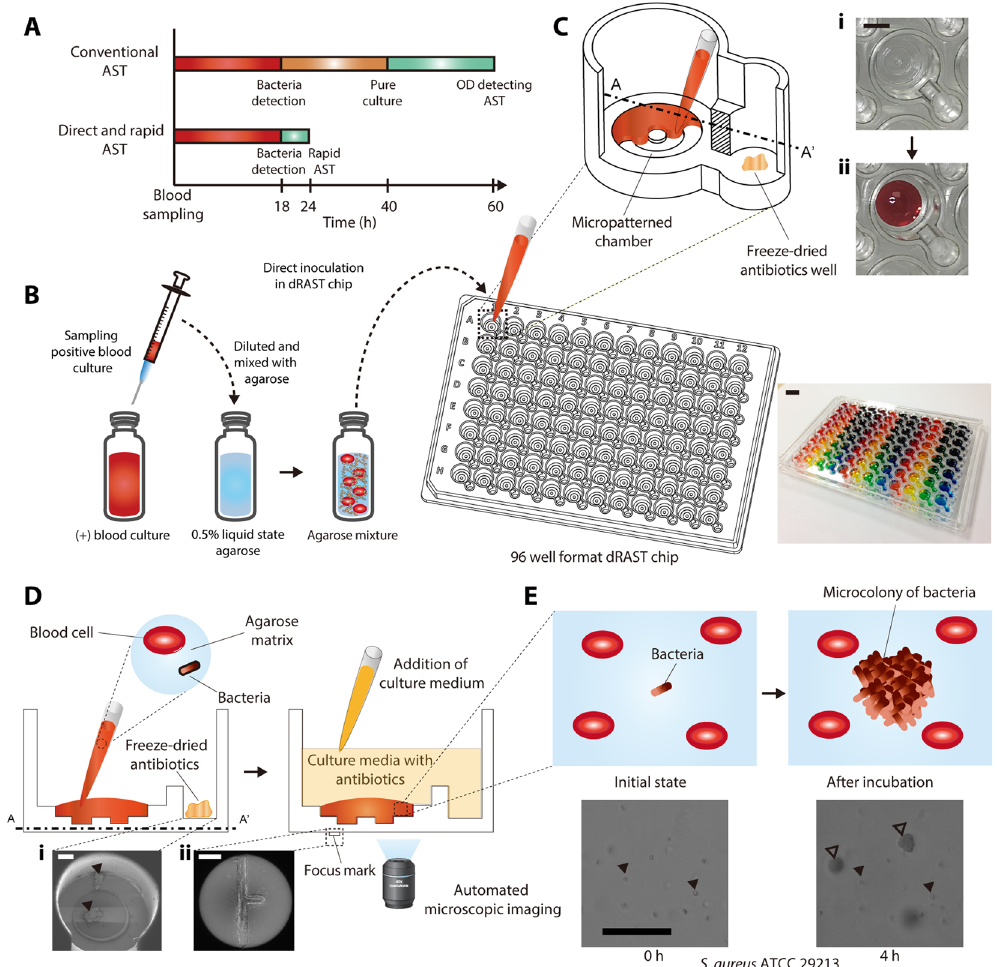
Figure 1. Device for the direct detection of antibiotic resistance from positive blood culture bottles (PBCBs). ( A ) The conventional AST system requires three separate culture processes: blood culture for positive infection detection, subculture for separation of bacteria from blood cells, and AST via optical density measurement; the total time to result is approximately 60 hours. The direct and rapid AST (dRAST) system developed herein does not require a subculture process and enables AST to be performed in six hours. The total time to result of dRAST is less than 24 hours. ( B ) Process of preparing a dRAST chip from a PBCB. A PBCB aliquot was diluted and mixed with liquid-state agarose. The mixture was inoculated into a dRAST chip consisting of 96 test wells containing various antimicrobials at several concentrations. ( C ) Detailed structure of a dRAST chip well. Each test well consists of a micropatterned radial chamber for agarose matrix molding and a satellite well for freeze- dried antibiotics. Inset images show the micropatterned chamber i) before agarose mixture loading and ii) after agarose mixture loading. ( D ) Experimental process for detecting bacteria in blood. A sample from a PBCB is mixed with agarose and loaded into the loading chamber in the chip. Freeze-dried antibiotics are rehydrated by adding culture medium (CAMHB). Automated microscopic imaging is used to detect bacterial growth. Inset scanning electron microscope (SEM) images show (i) freeze-dried antibiotics in the satellite well and (ii) the focus mark on the bottom of the chip for automated imaging. (E) In the initial state, bacteria were not detectable using a 20x magnification lens; only blood cells were detectable. After four hours of incubation, in the case of resistance to the antibiotic, a single bacterium divided and formed a microcolony. Filled triangle represents a blood cell. Unfilled triangle represents a bacterial microcolony. The scale bar represents 10 mm in (B) , 3 mm in (C) , 300 μ m in (D) , and 100 μ m in (E)